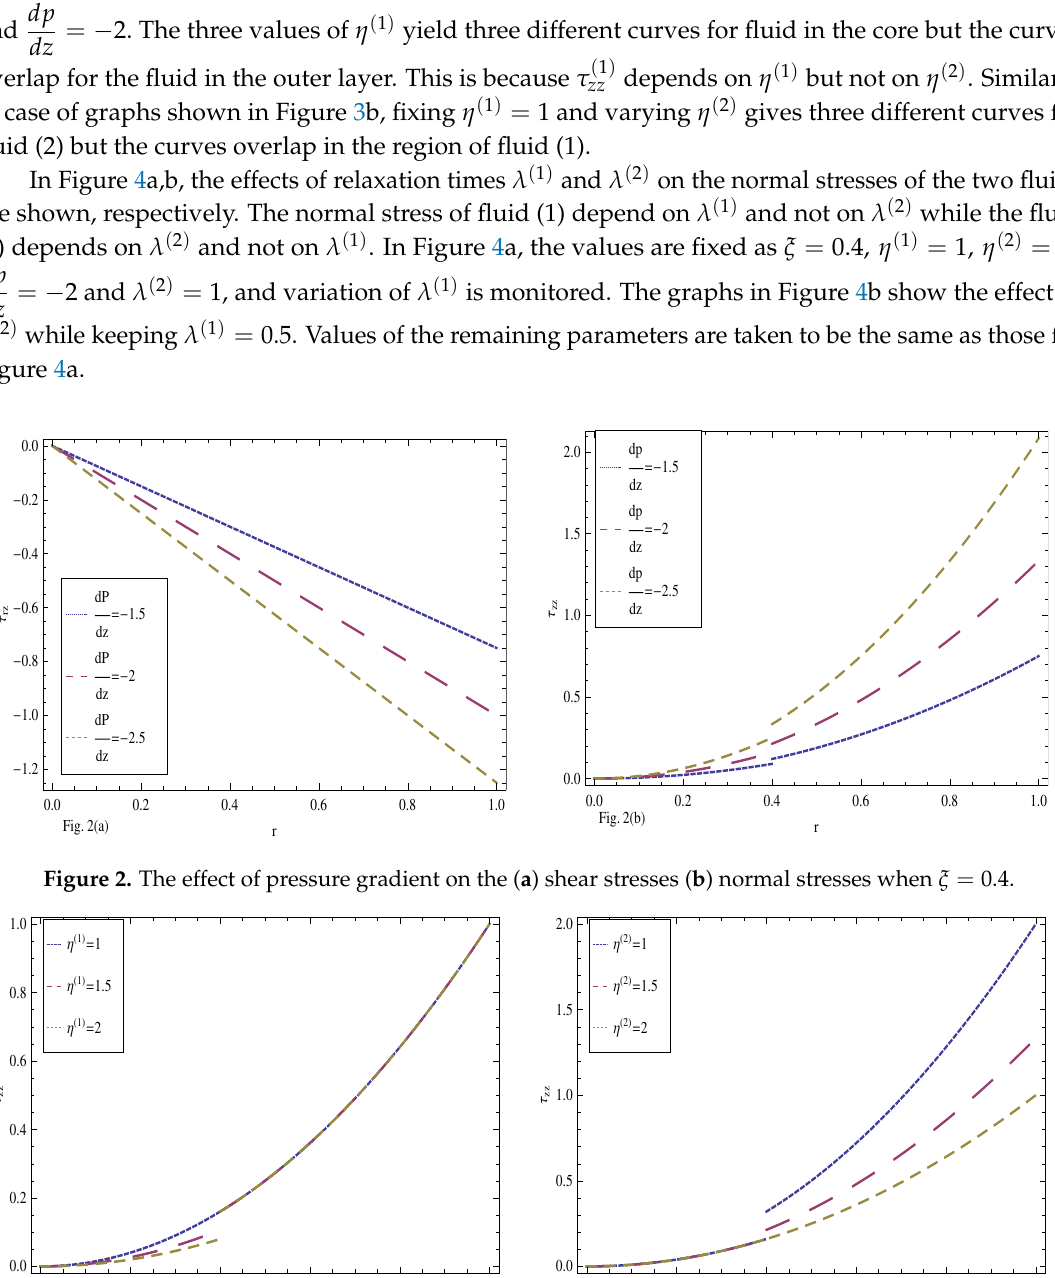
0.0 Figure 3. The effect of ( a ) viscosity coefficient η ( 1 ) , ( b ) viscosity coefficient η ( 2 ) , on the normal stresses of the two